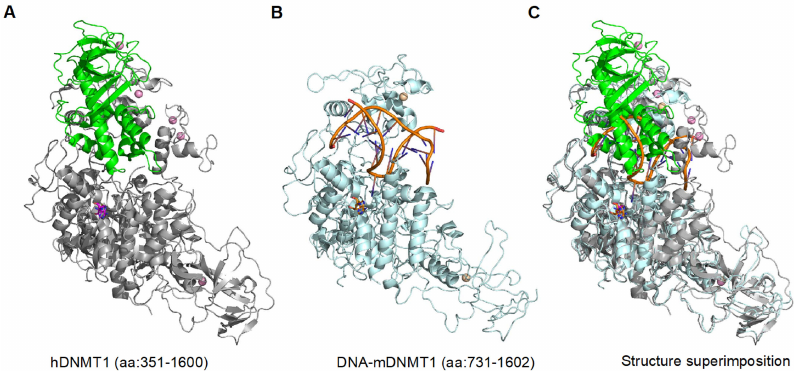
Figure 2. The DNMT1 replication foci targeting sequence (RFTS) domain regulates DNMT1 enzymatic activity through an auto-inhibitory mechanism. ( A ) Crystal structure of human DNMT1 (aa: 351-1600; PDB: 4WXX) in free form [23]. ( B ) Crystal structure of mouse DNMT1 (aa:731-1602; PDB: 4DA4)